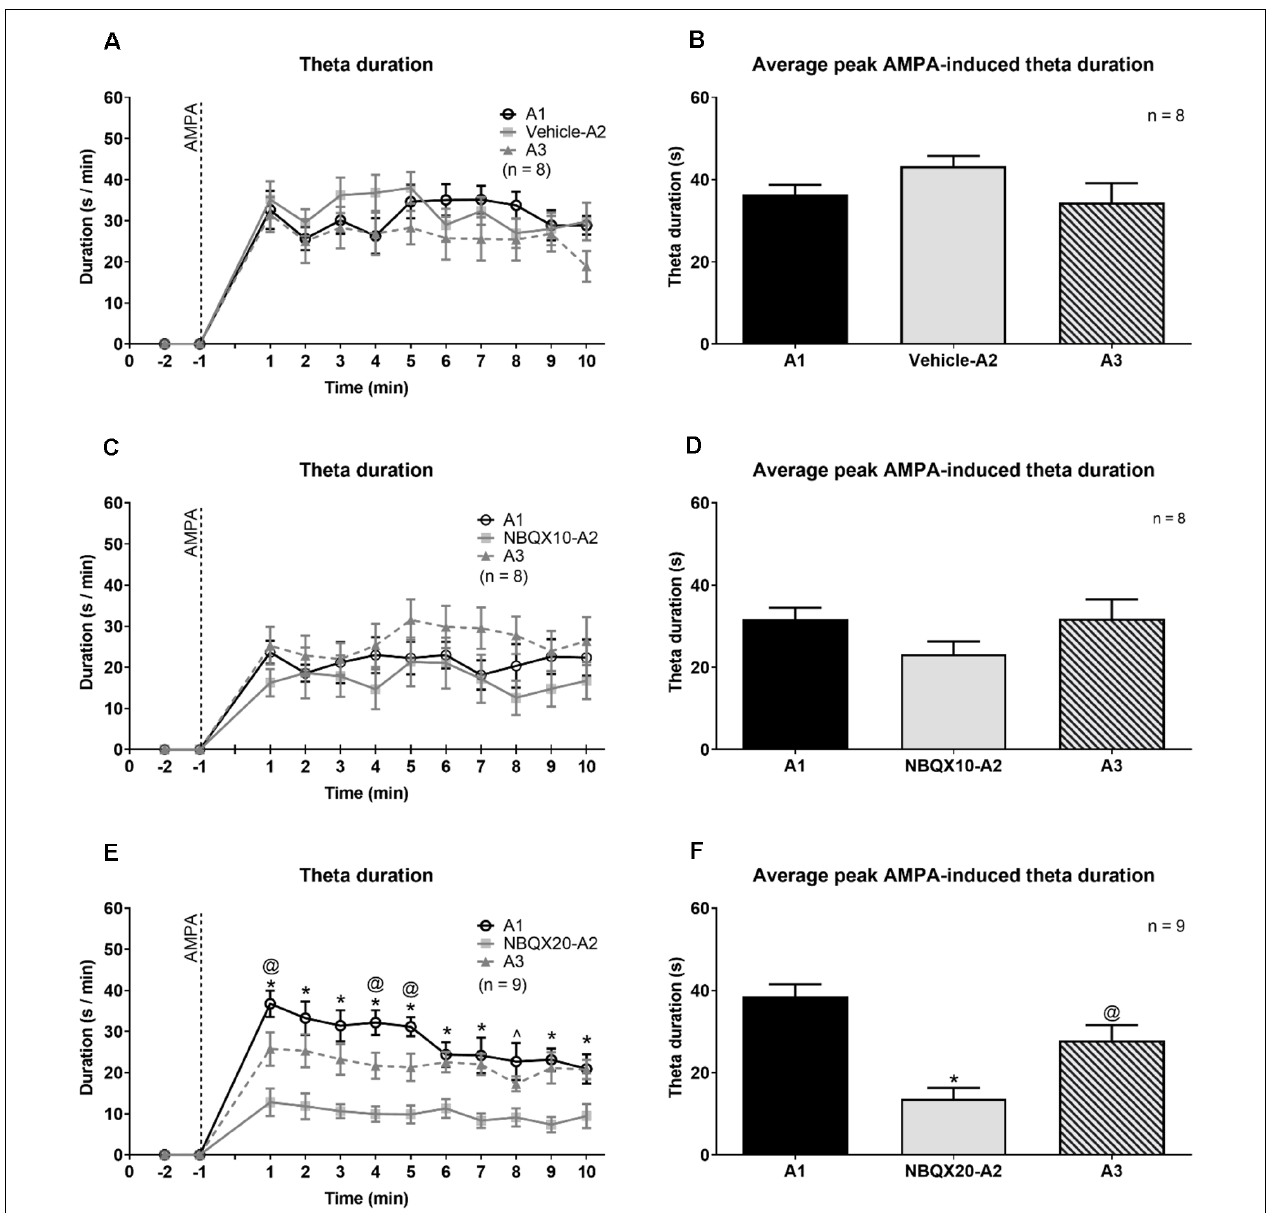
FIGURE 4 | The highest dose of NBQX, AMPA receptor antagonist, attenuates the duration of theta wave activity induced on microinjection of AMPA. The figure is developed as explained in Figure 3 . On left are time courses representating the effect of Vehicle (A) , NBQX10 (C) and NBQX20 (E) on the duration of AMPA-induced theta wave activity. The duration of theta was calculated as the sum of visible theta in a 1-min block. The histogram on right of the time courses (B,D and F) are the corresponding average peak AMPA-induced theta duration which was calculated as the average of the highest value of duration in two contiguous minutes in the first 5 min following microinjection of AMPA (left panel) and the histograms highlight the average highest value of that theta duration in two contiguous minutes in the first 5 min following microinjection of AMPA (right panel). Only the first 10 min, corresponding to the peak of AMPA effect following its’ microinjection, were analyzed. The protocol for drug microinjection is as explained in Figure 3 . Note that NBQX (20 µ g/ µ l), but not Vehicle or NBQX10, significantly antagonized AMPA-induced theta activation (E,F) . Data are mean ± S.E.M. Significant difference ( p < 0.05): (A,C, and E) Time course: *NBQX20-A2 vs. A1 and A3, @ A3 vs A1, ∧ NBQX20-A2 vs. A1; two-way RM ANOVA followed by Bonferroni post hoc test. (B,D, and F) Histograms: *vs. A1 and A3, @ vs. A1; one-way RM ANOVA followed by Newman-Keuls post hoc test.